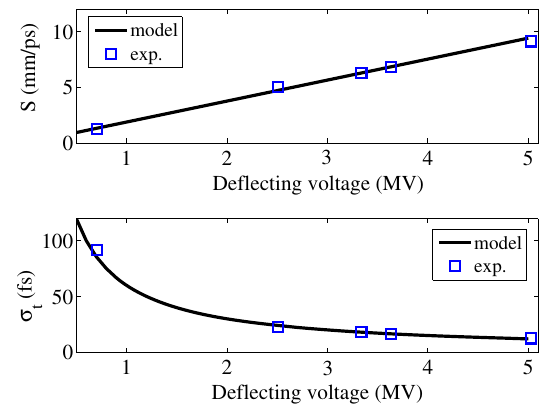
FIG. 34. Deflector calibration factor (top) and time resolution (bottom) as a function of the integrated deflecting voltage, measured in each case at the zero crossing of the rf phase, for a beam energy of 200 MeV and compared to model expectation